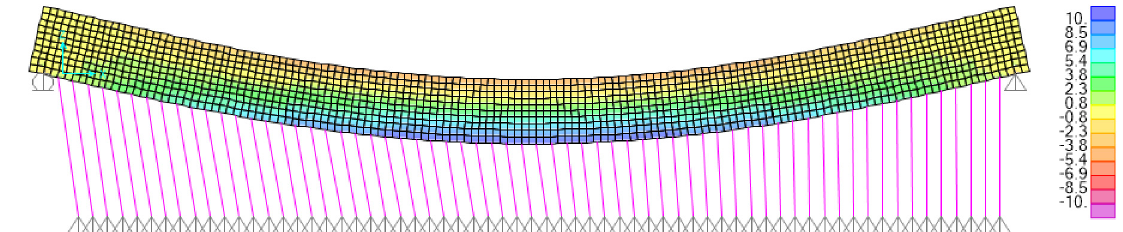
Figure 29. A 3D representation of bridge Span-2 in FE model.